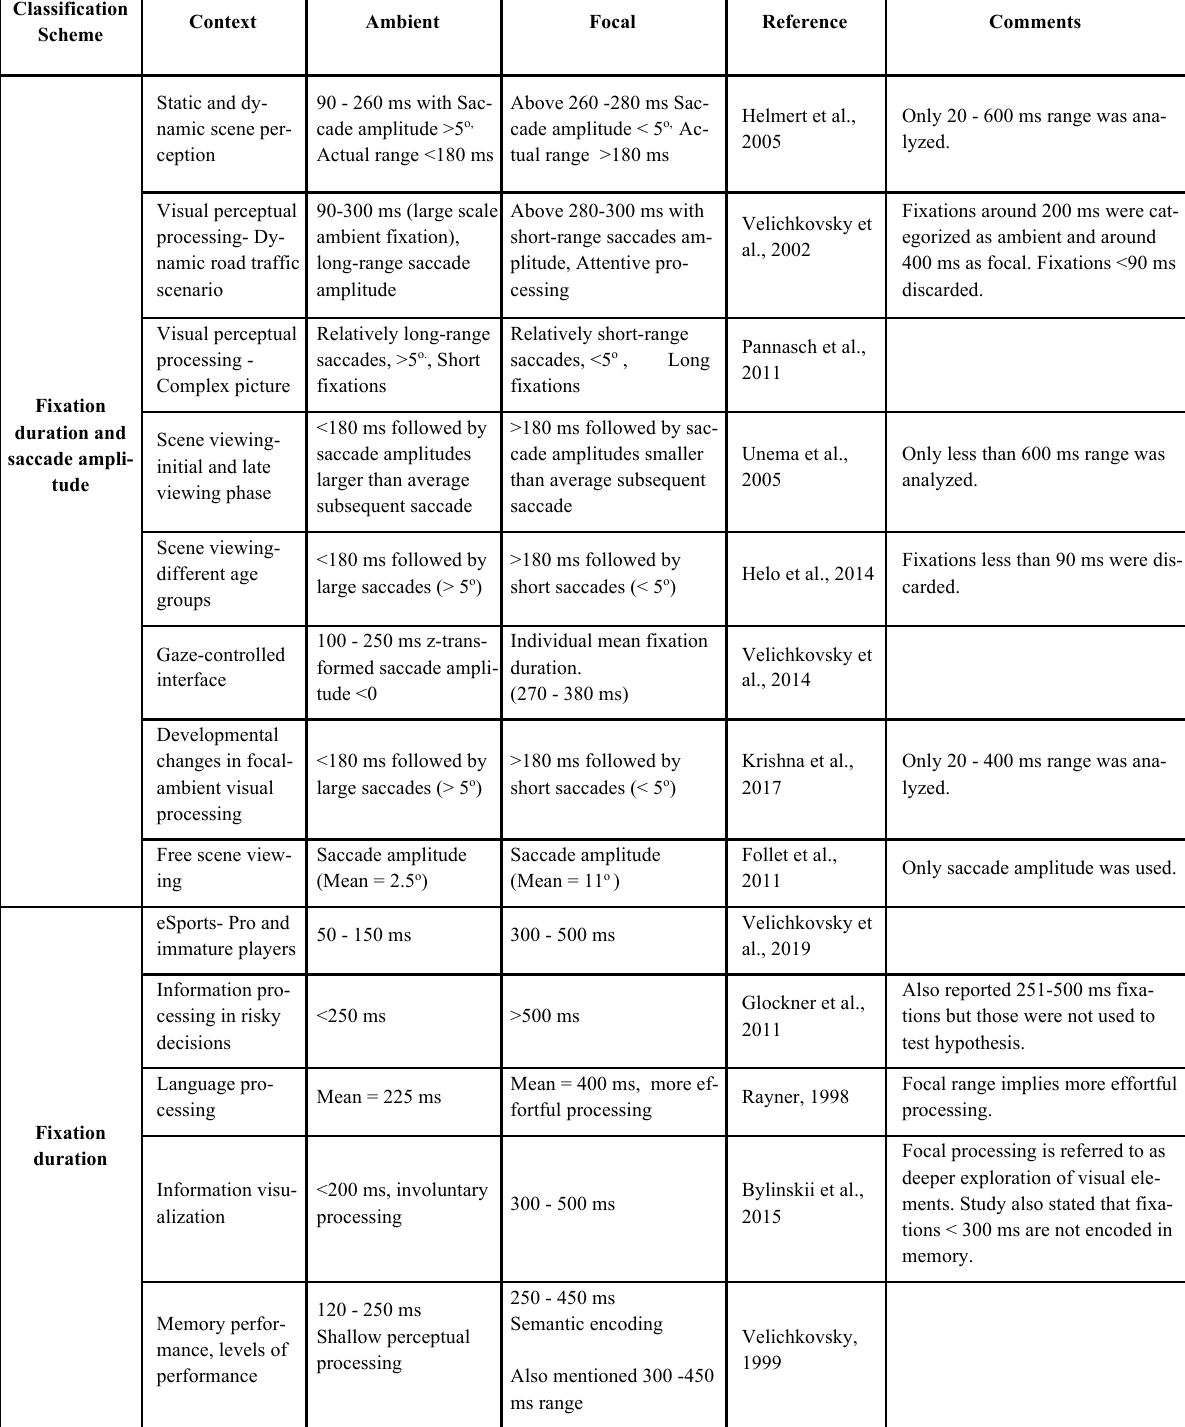
Table 1. Summary of literature review based on ambient and focal fixation